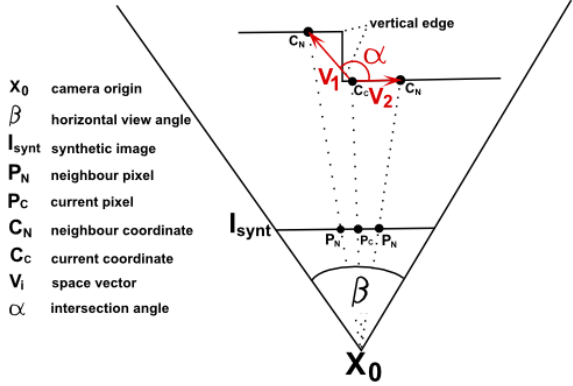
Figure 4: Schematic visualisation of the edge detection approach Figure 4 exemplary outlines the mentioned angle between two vectors of one gradient. The figure shows the horizontal gradient from west to east in the image as the projection of I synt and the corresponding vertical edge in the object space. Each pixel ( P i ) in I synt has additional 3D information ( C i ) which will be used to construct vectors in space. These red marked vectors point from the current pixel to the western and eastern adjacent pixel at an intersection angle ≤ 180 degrees and thus they refer to an edge